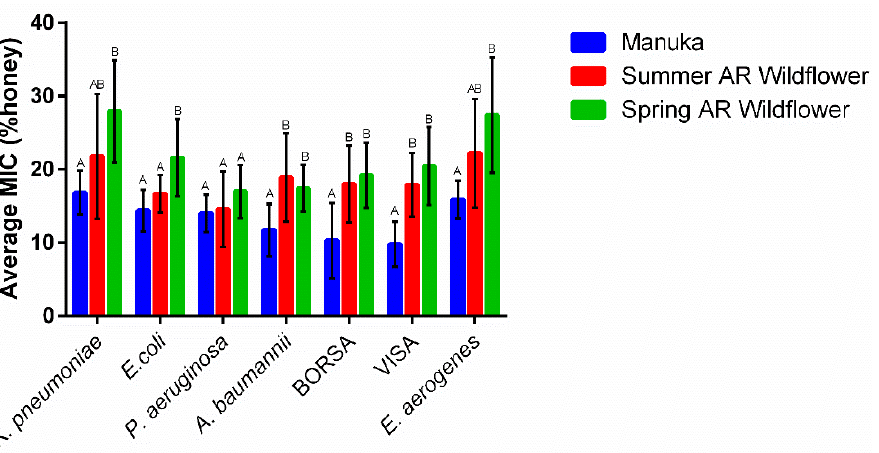
Figure 7. Comparison of the average MICs for each bacteria species tested (mean ± SD). The MICs of manuka and spring Arkansas honey were significantly different for K. pneumoniae , E. coli , A. baumannii , BORSA, VISA, and E. aerogenes (one-way ANOVA, Tukey; p = 0.0005, p = 0.0002, p = 0.0047, p = 0.0002, p < 0.0001, p = 0.0003, respectively). Manuka is also significantly more effective than summer Arkansas honey for A. baumannii , BORSA, and VISA (one-way ANOVA, Tukey; p = 0.002, p = 0.0043, p = 0.001 respectively), which are generally the most sensitive organisms. Summer Arkansas honey is only significantly different from spring Arkansas honey for E. coli (one-way ANOVA, Tukey p = 0.0238), and there is no significant difference across honey types for P. aeruginosa (one-way ANOVA, p = 0.1450). Additional p -values are in Supplemental Table S2. Columns with equivalent letters (e.g. A and A) are statistically similar while columns with different letters (e.g A and B) are statistically different.